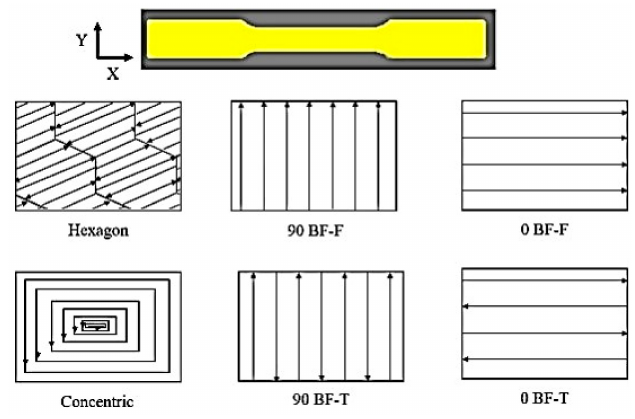
Figure 8. Schematic diagram of di ff erent scanning strategies [129]. Table 3. The e ff ect of scanning strategy on the average amount of austenite phase, 17–4